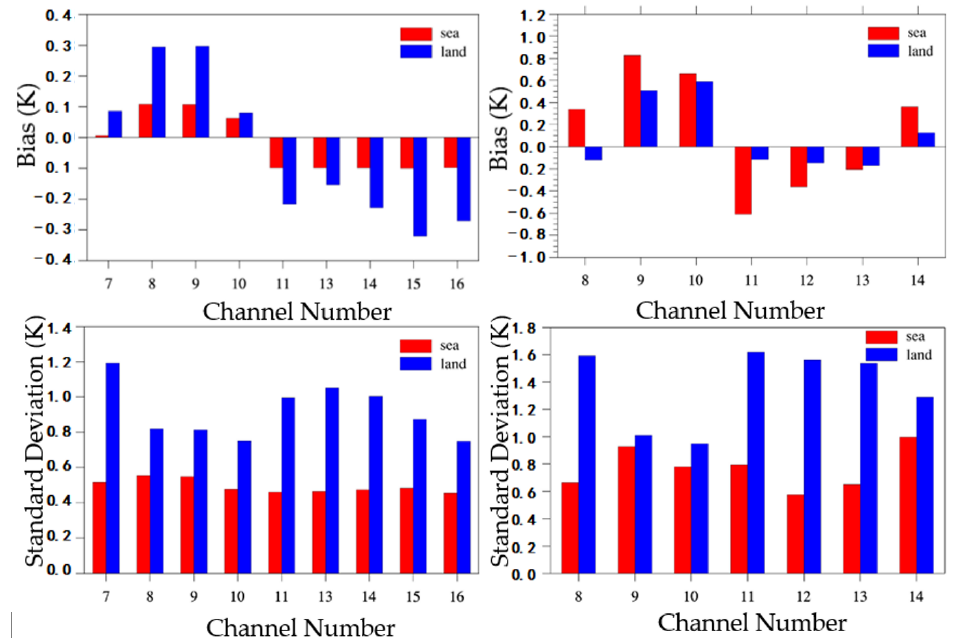
Figure 2. Mean ( top ) and standard deviation ( bottom ) values of O-B for different channels of AHI (left column) and AGRI (right column) sensor data collected over the ocean (red) and land (blue) areas.